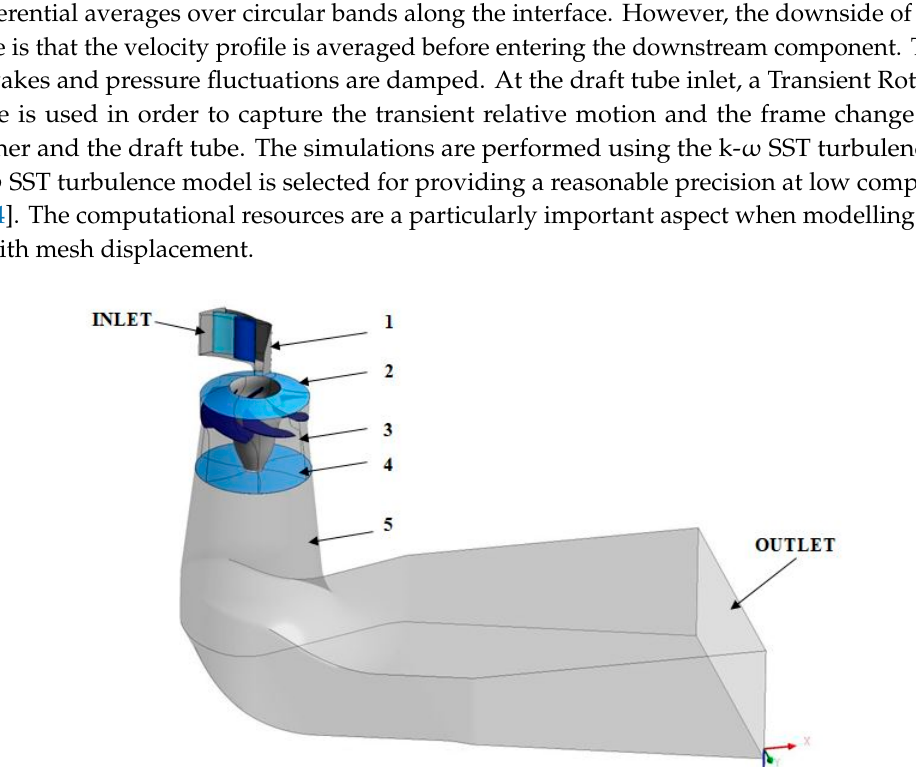
Table 2. Quality parameters of the mesh used in the transient simulations.